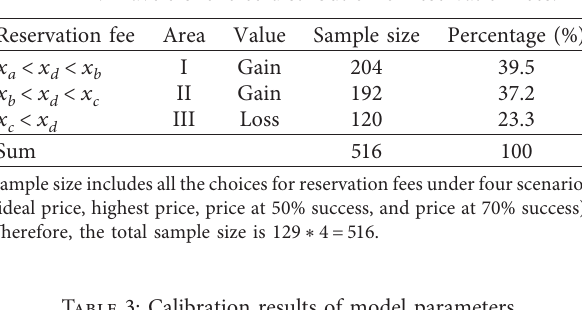
Figure 11: The prospect value under different choices of parking reservation fee.